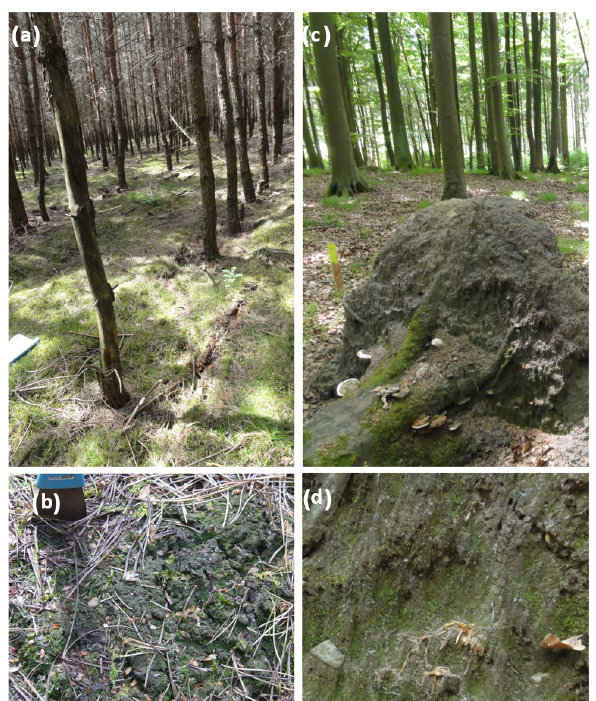
Figure 1. General overview of managed pine forest (a) , natural beech forest (c) and close-up of the respective biological soil crusts (BSC): BSC on bare soil in a managed pine forest (b) ; BSC on a root plate of a fallen tree in a natural beech forest (d)